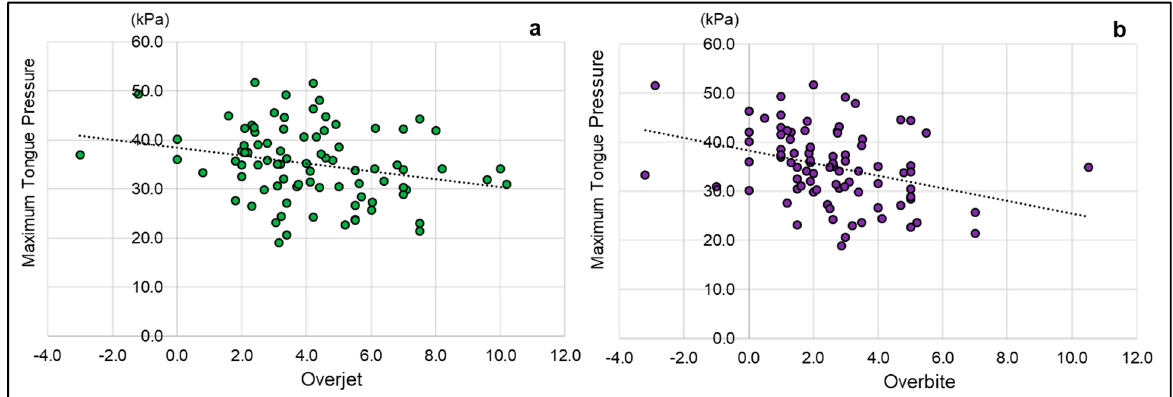
Figure 5. Correlation between MTP and overjet ( a ) and overbite ( b ).